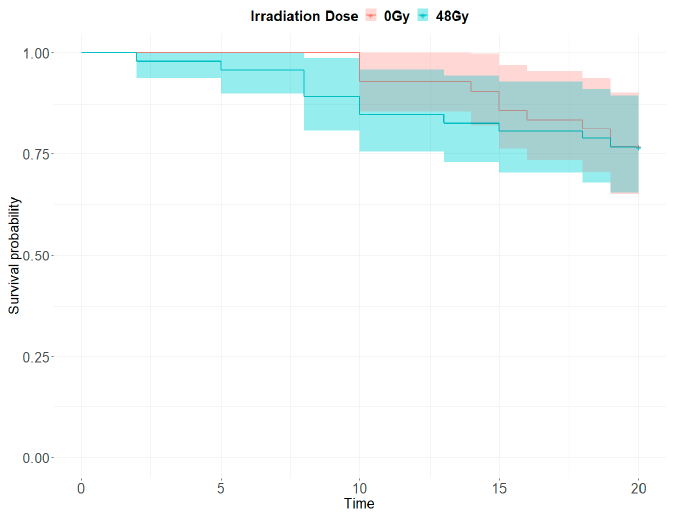
Figure 4. Survival plots of irradiated (48 Gy) and untreated (0 Gy) male Aedes albopictus over 20